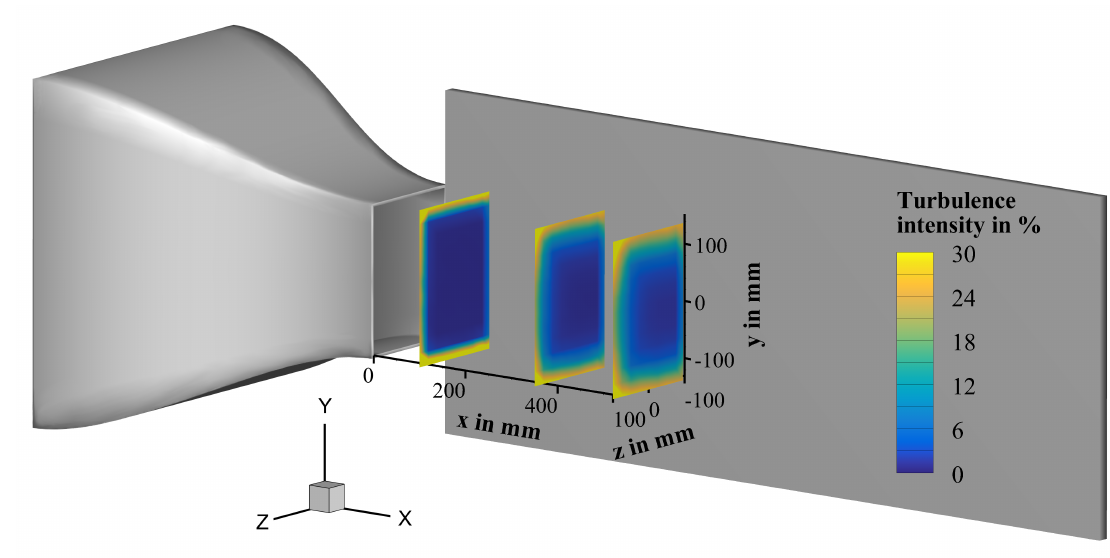
Figure 7. Turbulence intensity at 45ms − 1 with a distance x = 100, 350 and 520mm from the nozzle outlet.